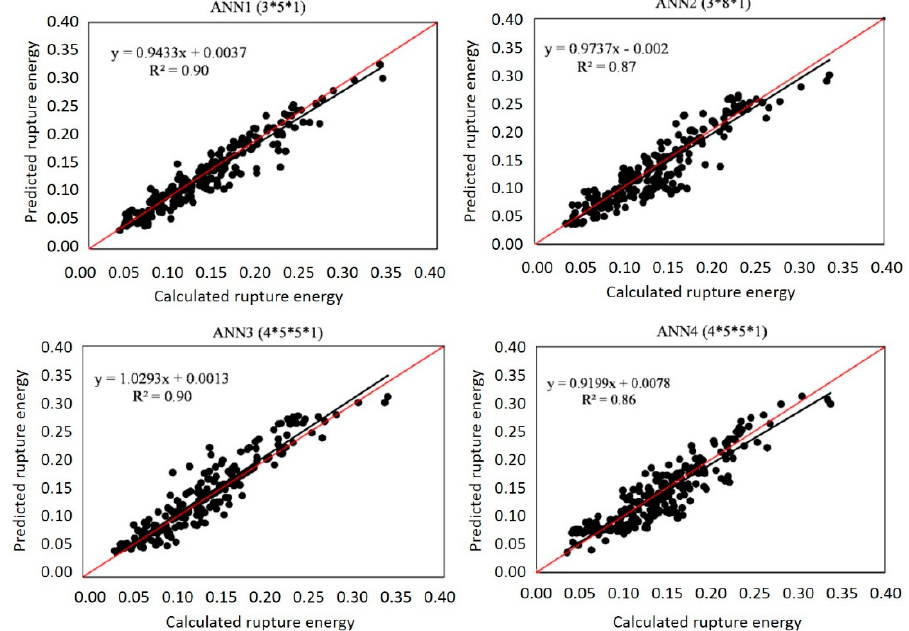
Figure 2. Rupture energy results for all data by the best ANN models.